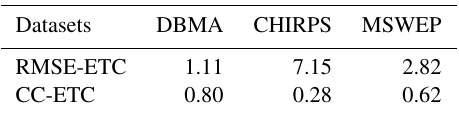
Table 6. Statistical RMSE and CC of merged datasets calculated by the ETC